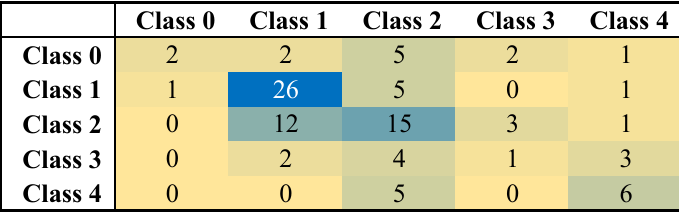
Figure 5. Confusion